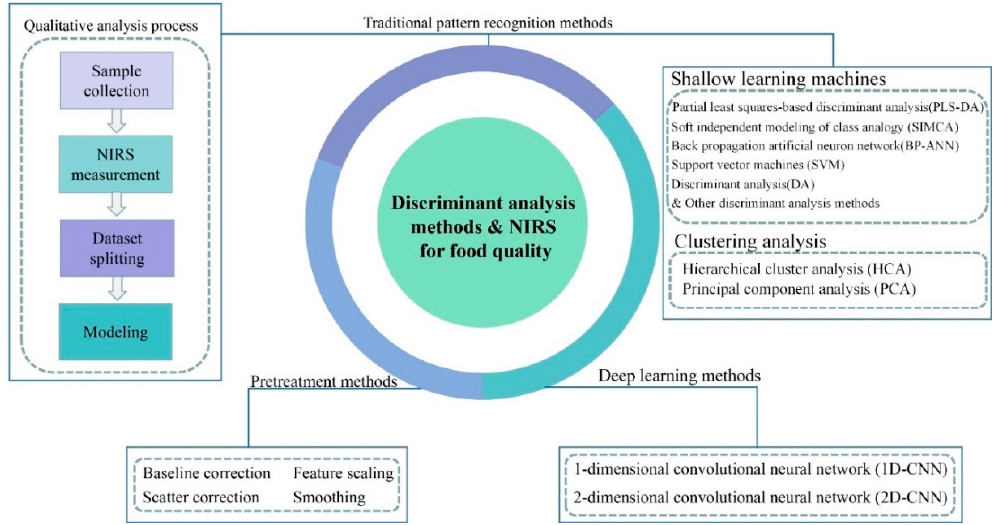
Figure 1. The organizational structure of the article.